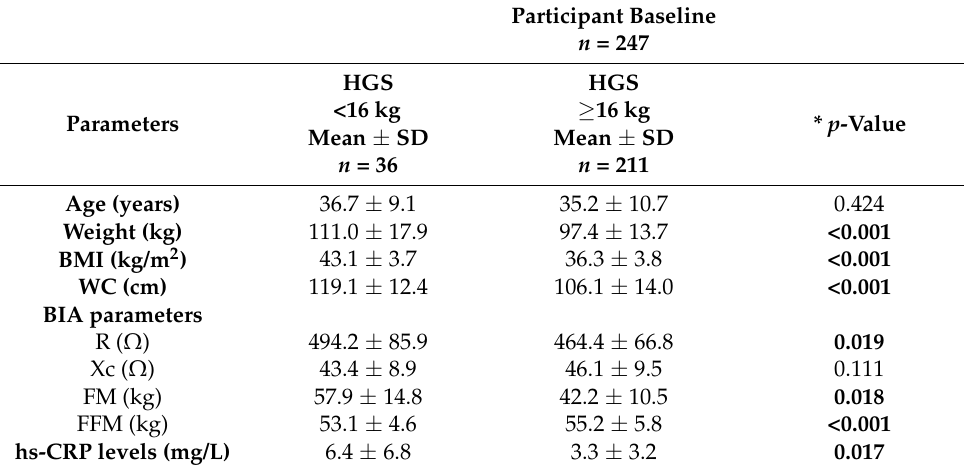
Table 3. Anthropometric measurements, body composition, and hs-CRP levels of the study popula- tion baseline grouped according to the cut-off of HGS.